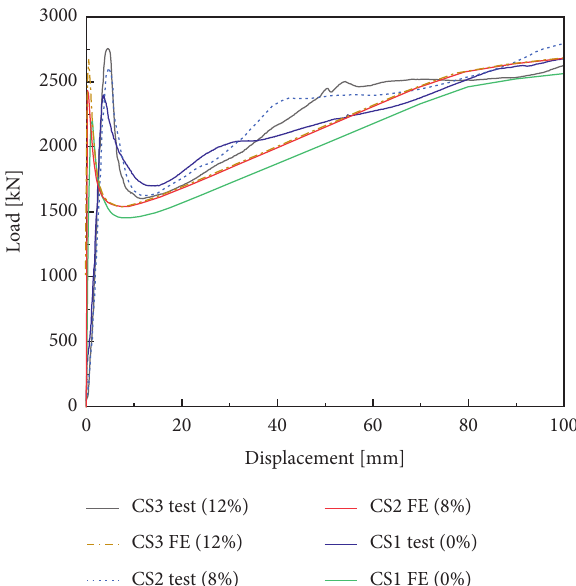
Figure 12: Load-displacement curve of the specimen.